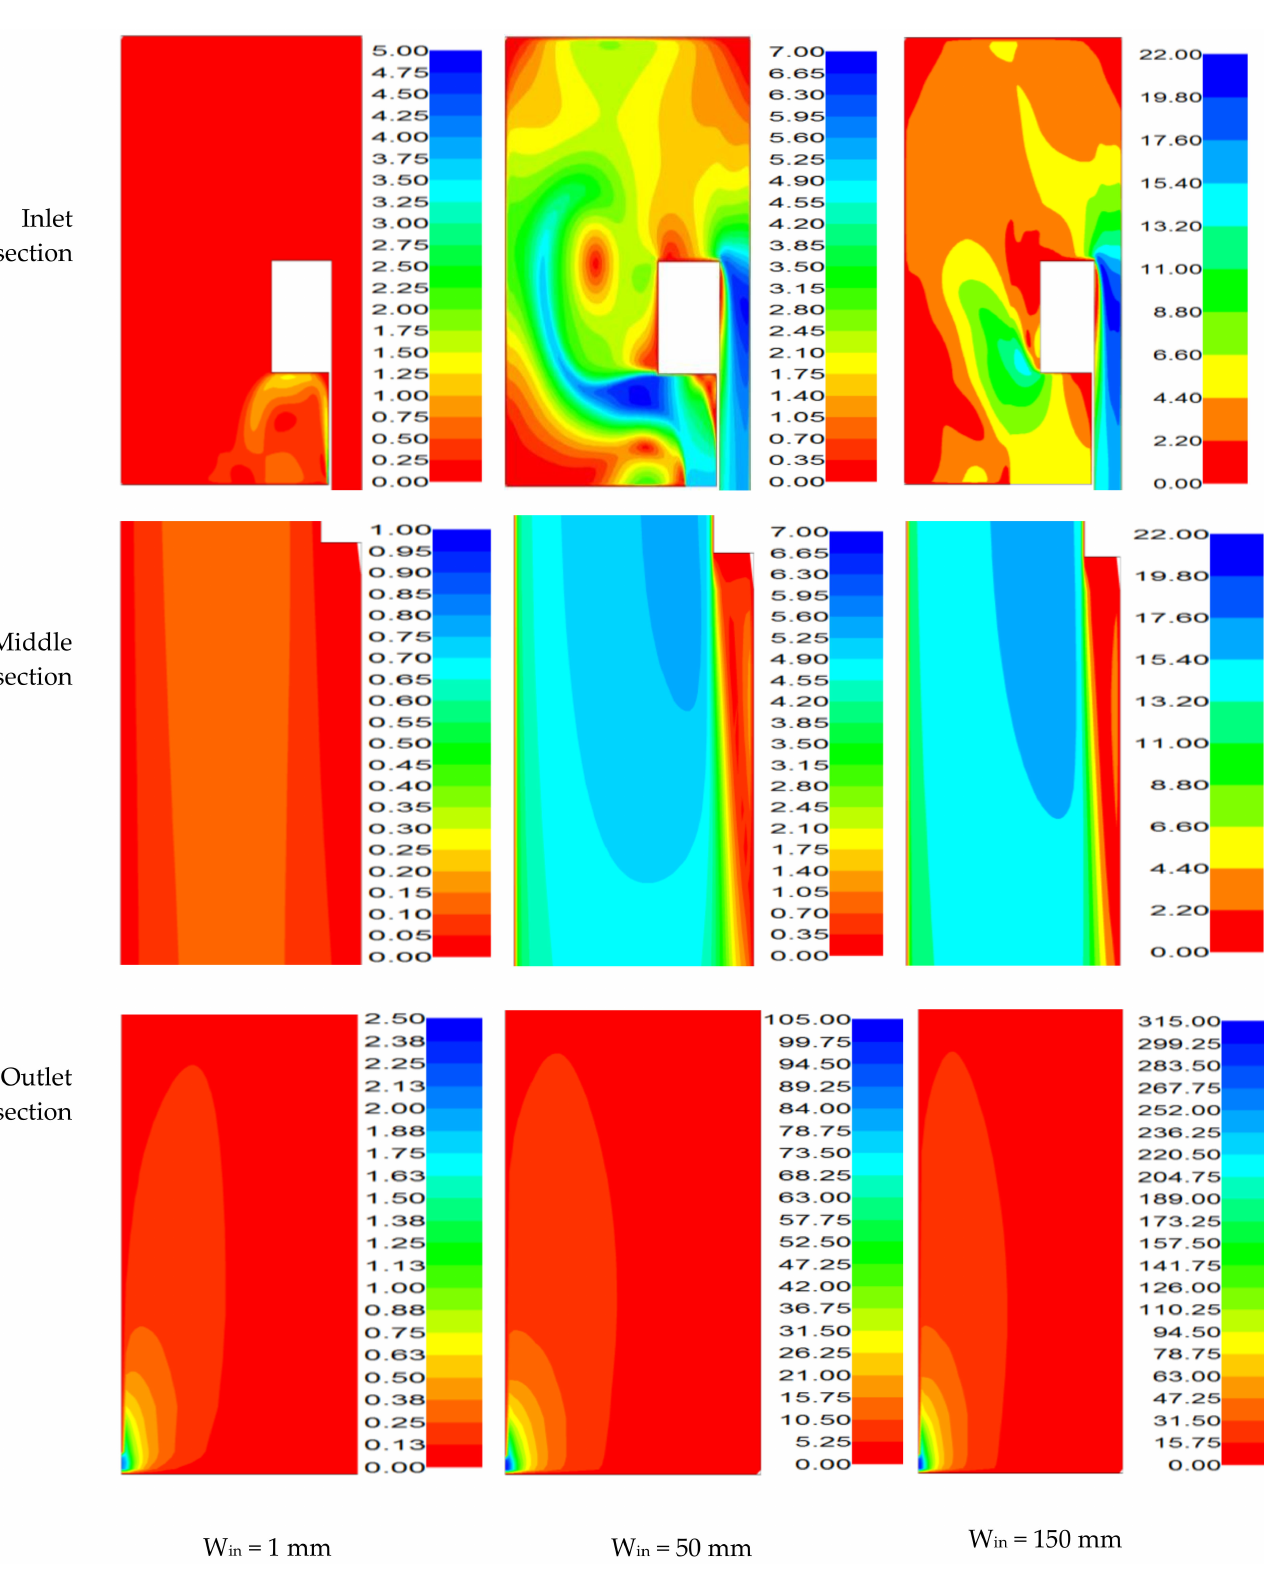
Figure 11. The change of wind speed cloud in the cavity with air inlet width (unit: m · s − 1 ). The main reason for this phenomenon is that under the fixed inlet width and inlet velocity, the inlet flow rate is constant; as air layer thickness increases, the entire cavity section average flow velocity decreases, the formation of the corner make air flow resistance increases, which further reduces the air velocity; thus, the convection